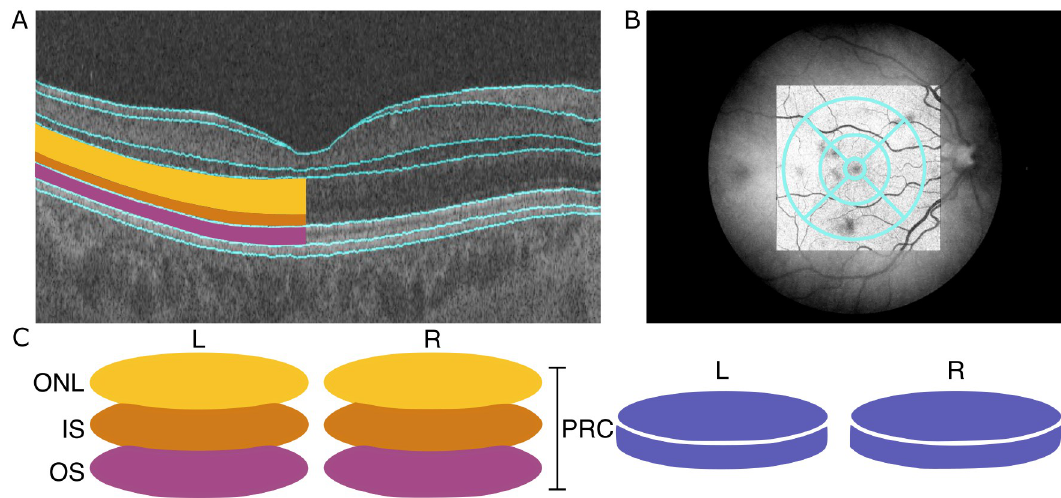
Fig 1. Data available from OCT images to describe morphology of the photoreceptor cell layer. (A) An optical coherence tomography (OCT) image of the cross-section of the retina. The layers are segmented, outlined in blue, by the Topcon advanced boundary software (TABS). On the left-hand side of the image, the PRC layers have been shaded: The outer nuclear layer (ONL) in yellow, the inner segment (IS) in orange and the outer segment (OS) in magenta. (B) The early treatment of diabetic retinopathy study (ETDRS) segmentation grid super imposed on a fundus image of the retina. The ETDRS grid is composed of nine segments arranged in a bulls-eye. (C) A schematic of the data utilised to describe PRC morphology as an input phenotype in genome-wide association studies (GWAS). The ONL, IS and OS, combined, comprise the photoreceptor cells (PRC).